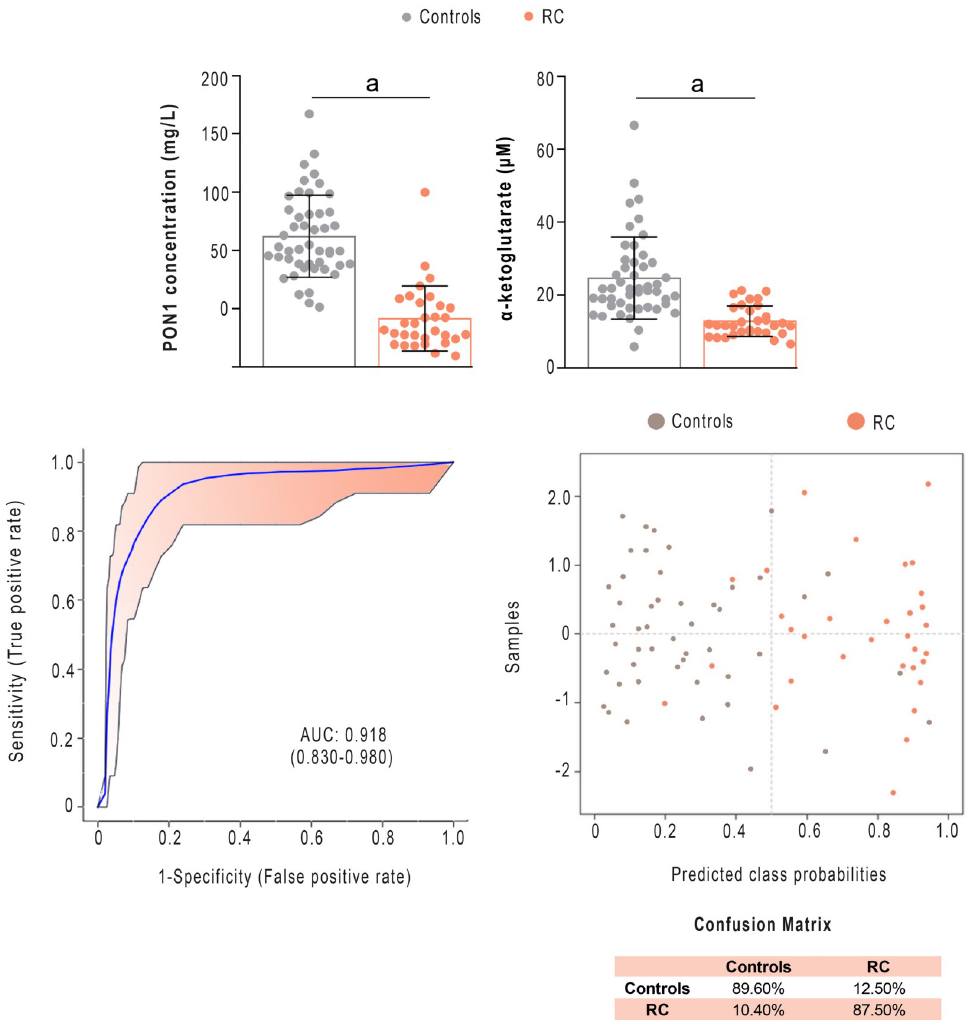
Fig 5. Serum Paraoxonase-1 (PON1) and α -ketoglutarate concentrations discriminate between patients with Rectal Cancer (RC) and the control group. PON1 and α -ketoglutarate concentrations were significantly lower in patients than in healthy subjects. Receiver operating characteristics curve-based model evaluation and confusion matrix showed that the combination of these parameters was able to efficiently distinguish both groups. AUC: Area under the curve. a = p <